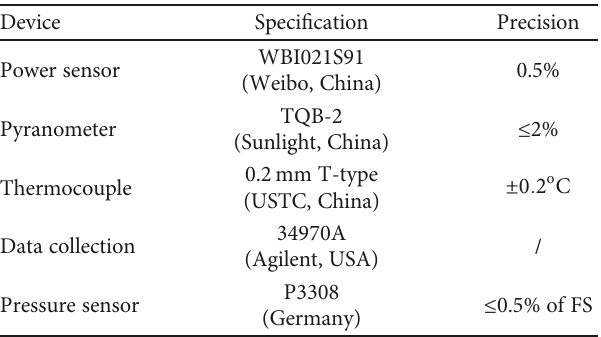
Figure 2: System physical setup and the detailed locations of the thermocouples ’ setup. Table 2: Manufacturers, models, and precisions of monitoring